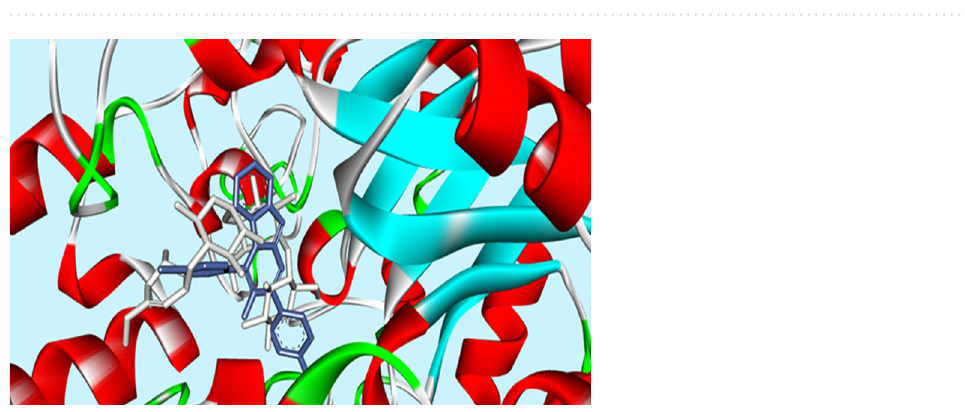
Figure 2. Kinetics of α-glucosidase inhibition by sample 3k . ( a ) The Lineweaver–Burk plot in the absence and presence of different concentrations of sample 3k ; ( b ) The secondary plot between K m and various concentrations of sample 3k . *This figure was created by Microsoft Excel 2016 (https:// www. micro soft. com/ en- us/ downl oad/ office. aspx).